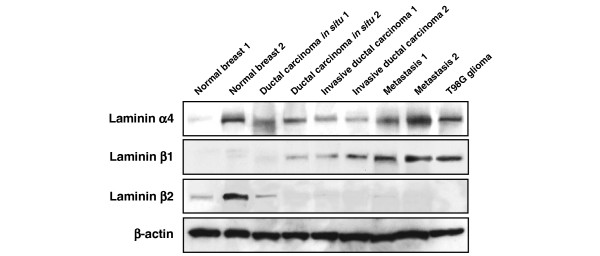
Western blot analysis. Shown are eight out of 28 samples (two normal breast samples, two DCIS, two IDC and two breast cancer metastases to brain) subjected to Western blot analysis for laminin α4, β1 and β2 chains. Gel loading was normalized by β-actin (lower row). The expression of laminin α4 chain, a constituent of laminin-8 and laminin-9, varies in normal and tumor tissues, with the highest expression detected in metastases. Laminin β2 chain, a constituent of laminin-9, is highly expressed in normal tissues, but its expression is very low in breast cancer tissues. In contrast, expression of laminin β1 chain, a constituent of laminin-8, is high in brain metastases and IDC but low in DCIS and absent in normal tissues. Laminin α4 chain migrates at 200 kDa, β1 chain at 230 kDa, β2 chain at 190 kDa, and β-actin at 47 kDa. The T98G glioblastoma cell line, which is known to express α4 and β1 chains of laminin-8 but no β2 chain, is used as a positive control.